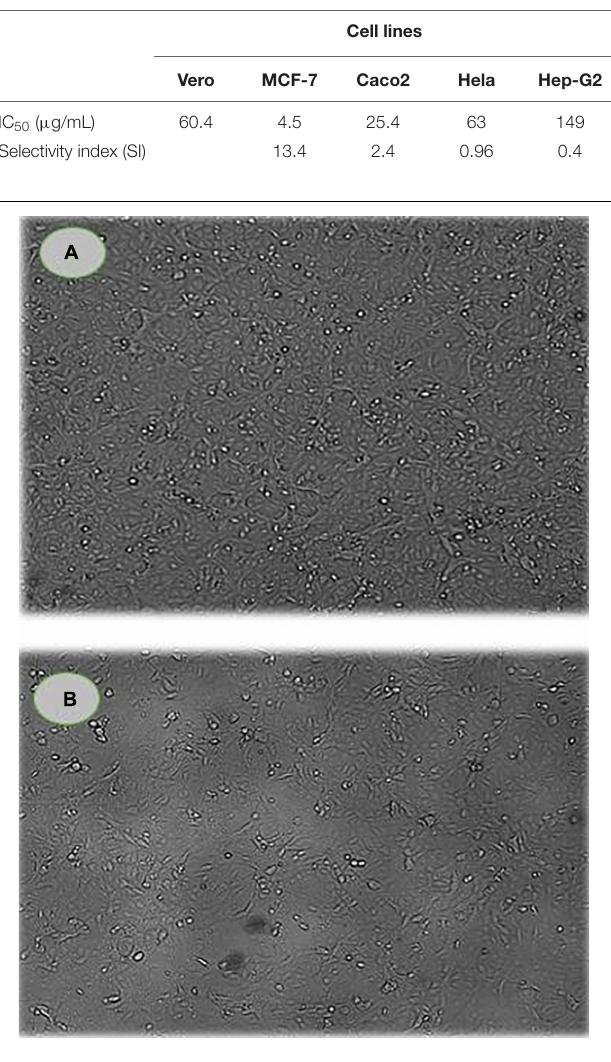
FIGURE 4 | Cell viability and morphology of MCF-7 cells. (A) control cells; (B) PoPE-cultured MCF-7 cells (5 µ g/mL). There was a significant cell size decrease and dead cells as a sign of apoptosis in treated